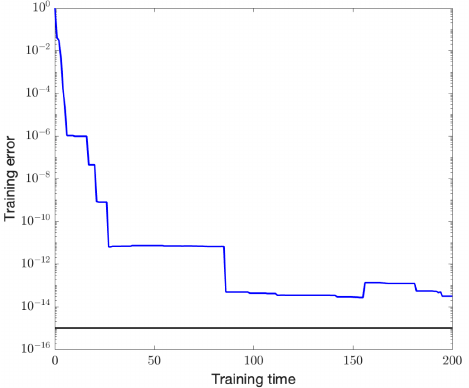
Figure 6. One-dimensional logistic error iterative convergence curve. The blue line is the error iteration convergence curve, and the black line is the iteration termination condition set at 10 − 15 .